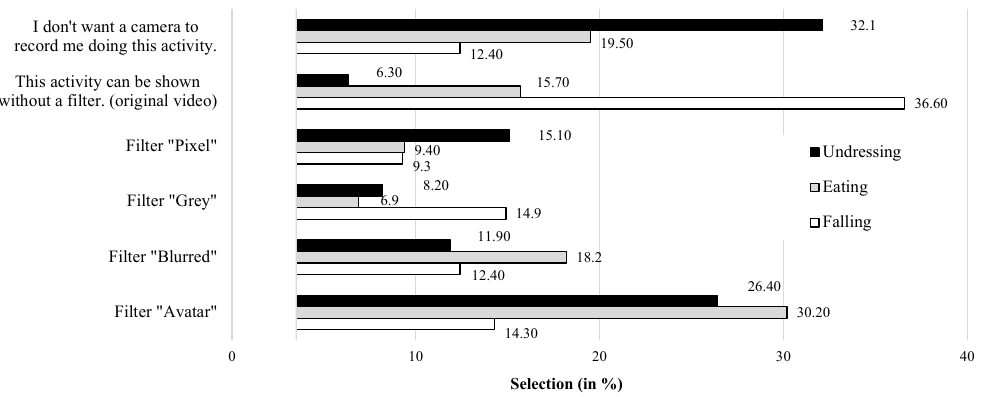
Figure 6. Selection of visualization modes in different situations (n = 161).